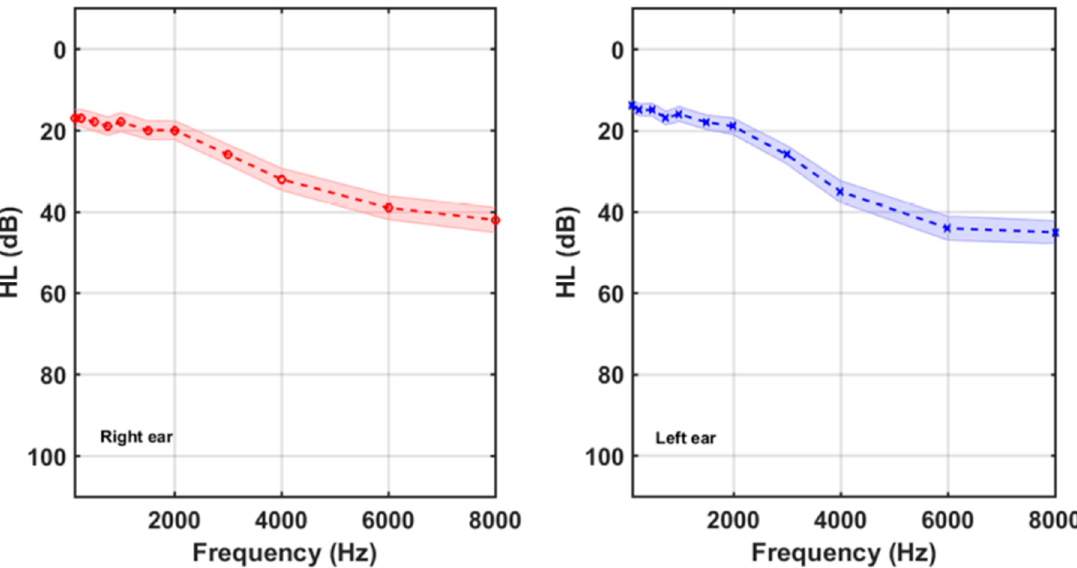
Figure 2. Right and left average audiograms of the 83 participants. Shaded areas around the mean curves display the 95% confidence intervals.